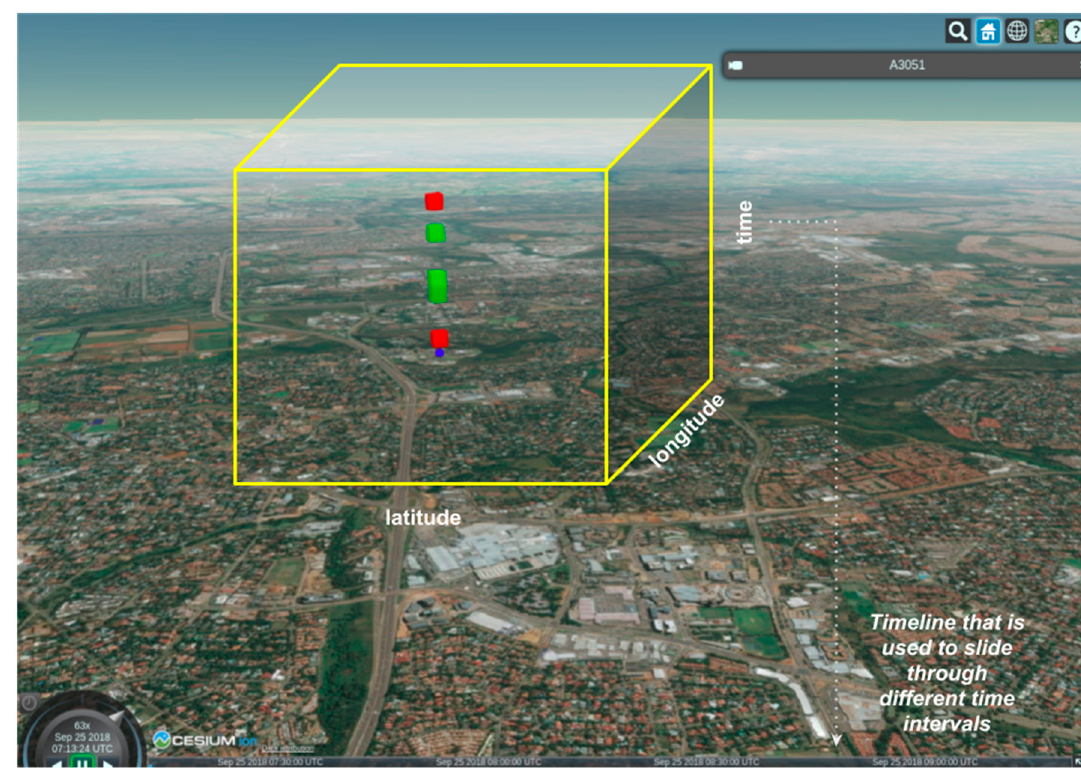
Figure 7. Observation of transient events at known stations on a Space Time Cube.